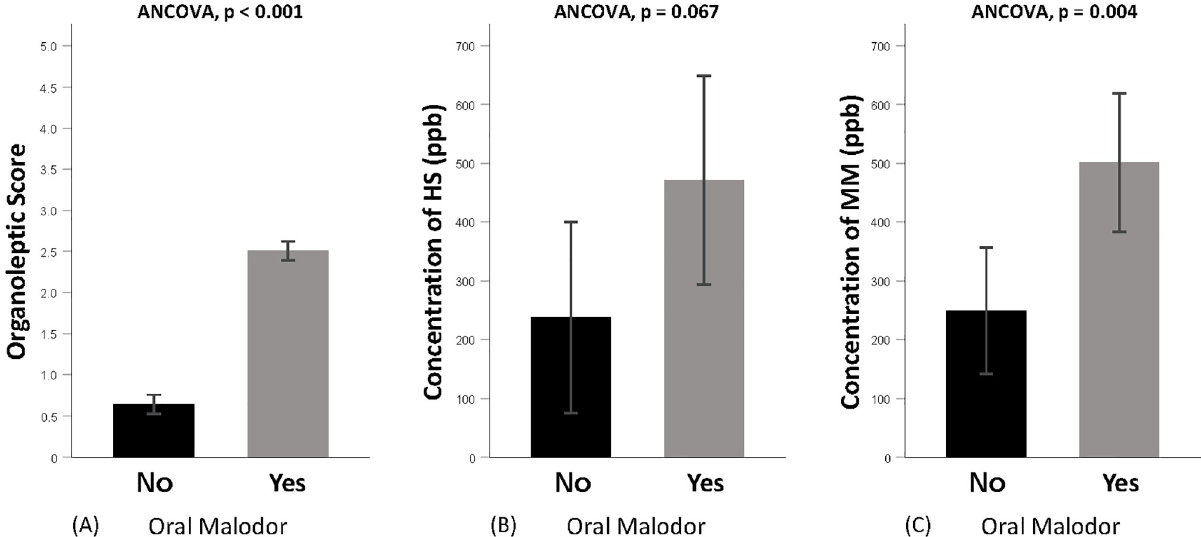
Fig 2. Adjusted relationship between oral malodor (OLS � 2) and oral malodor parameters ( n = 111). (A) organoleptic score; (B) concentration of hydrogen sulfide (HS); (C) concentration of methyl mercaptan (MM). Each bar and error lines represent the mean ± standard error for oral malodor no and yes groups. P values are obtained from ANCOVA adjusted for age, sex, education level, tooth-brushing frequency, denture-wearing, periodontitis, hyposalivation, tongue coating, preference for onion, drinking, smoking, obesity, diabetes, hypertension, ear-nose-throat diseases and gastrointestinal